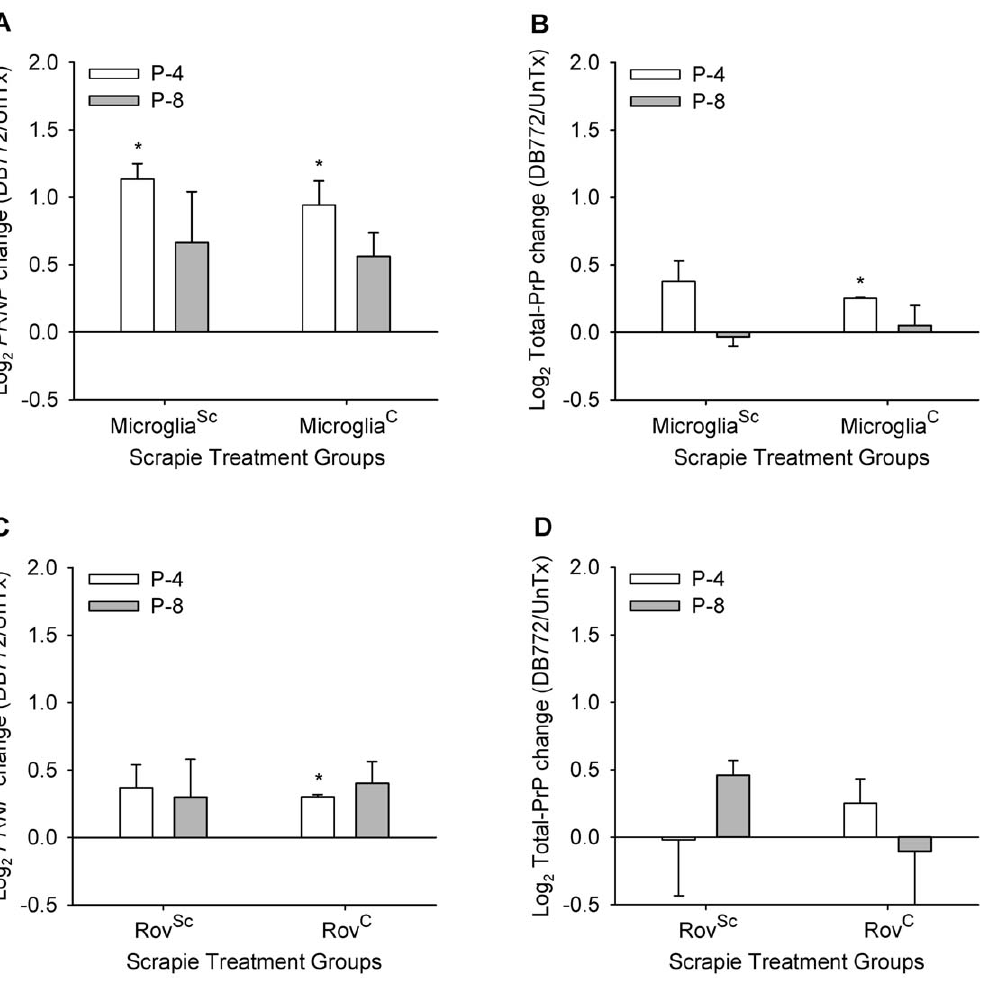
Figure 5. DB772 does not inhibit normal prion protein expression. Determination of DB772 9 s effect on PRNP transcript levels in primary sheep microglia (A) and Rov9 cells (C). RNA was collected at P-4 and P-8, and assayed via quantitative RT-PCR, using normalization to GAPDH . Columns represent the log 2 change in DB772-treated groups compared to untreated groups from the same scrapie-treatment categories and time points (positive values indicate DB772 enhances and negative values indicate DB772 inhibits PRNP transcript levels). Determination of DB772 9 s effect on total PrP concentration in primary sheep microglia (B) and Rov9 cells (D). Total protein was collected at P-4 and P-8, and assayed for total PrP C using a commercial ELISA. A standard curve was used to transform the corrected optical densities into relative concentration of PrP C . Columns represent the log 2 change in DB772-treated groups compared to untreated groups from the same scrapie-treatment categories and time points. Results at each passage and for each scrapie status were statistically compared individually, using individual one-sample t tests, to the null hypothesis of no effect of DB772. *, P , 0.0125. doi:10.1371/journal.pone.0051173.g005 of anti-pestivirus activity and follow-up experiments confirmed the anti-pestiviral activity of DB772 [56,57], the anti-pestivirus maximum anti-pestivirus activity at a concentration significantly TCEC 50 and TCEC 99 were not fully determined for these culture models. Instead, a single experiment was used to define the range different than the anti-PrP Sc TCEC 50 . The effective anti-pestivirus Table 2. Anti-PrP Sc activity and cytotoxicity of DB772 in sheep microglial cells and Rov cells.